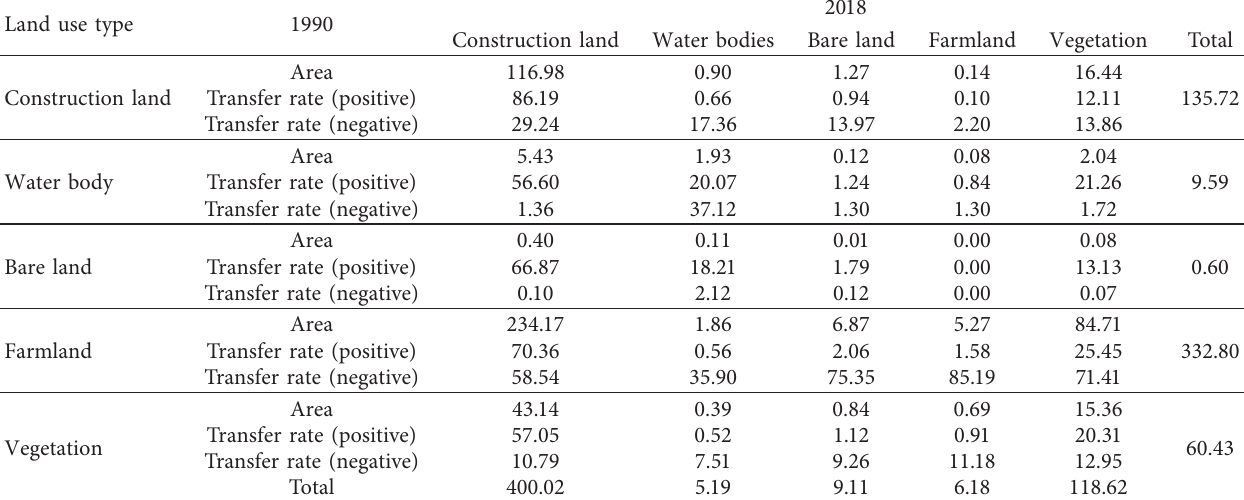
Table 3: Transformation matrix of land use in the central urban area of the study area from 1990 to 2018.